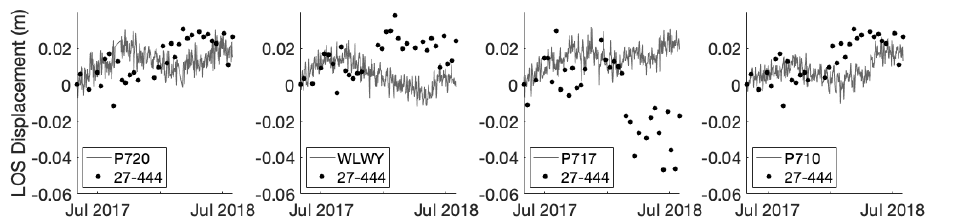
Figure 11. Comparison of GNSS displacement with displacement derived from the corresponding DInSAR pixel in the 27-444 frame. The displacements are shown in the LOS direction of the DInSAR data